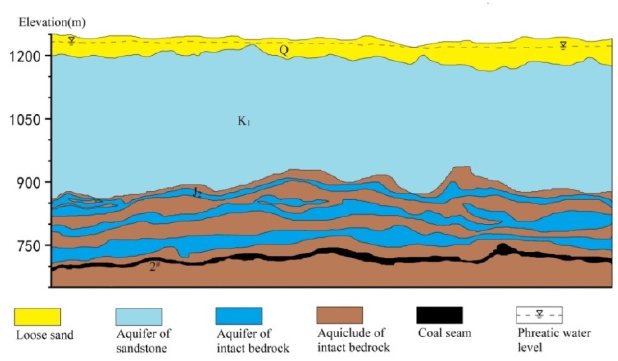
Figure 2. Schematic stratigraphic section of the study area.